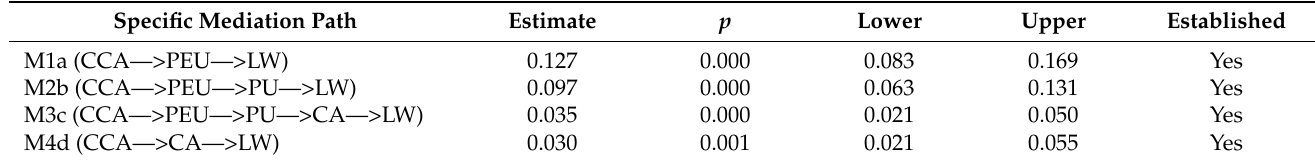
Table 7. Specific intermediary path test.